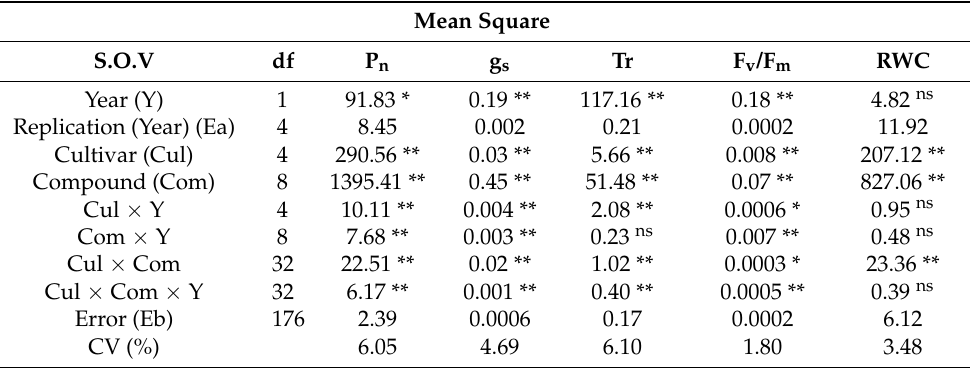
Table 6. Analysis of variance on the effects of chitosan and titanium dioxide treatments (bulk, nanoparticles) on the leaf gas exchange, photosynthetic state, and hydration status of five milk thistle ecotypes. P n , net photosynthetic rate; g s , stomatal conductance; T r , transpiration rate; F v /F m , ratio of variable to maximum fluorescence; RWC, relative water